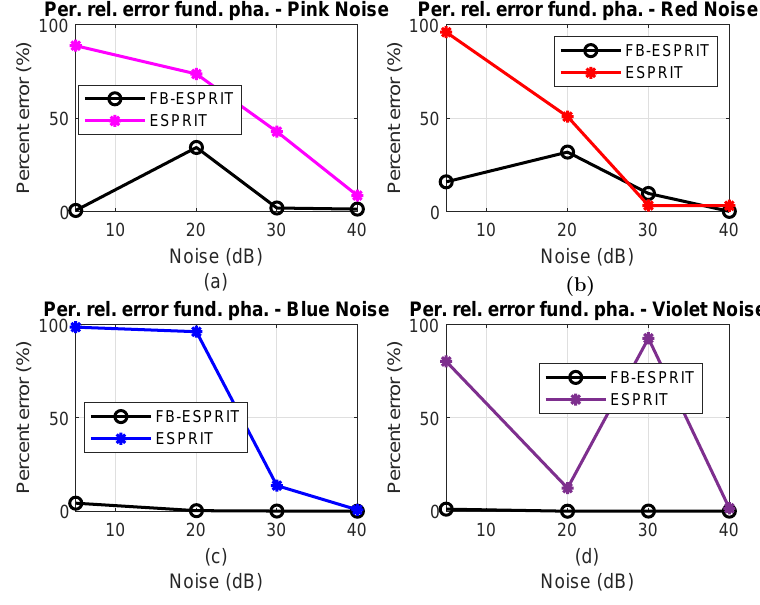
Figure 11. Percentage relative (Per. rel.) error (%) of 60 Hz fundamental component phase: ( a ) signal contaminated with pink noise, ( b ) signal contaminated with red noise, ( c ) signal contaminated with blue noise, ( d ) signal contaminated with violet noise.